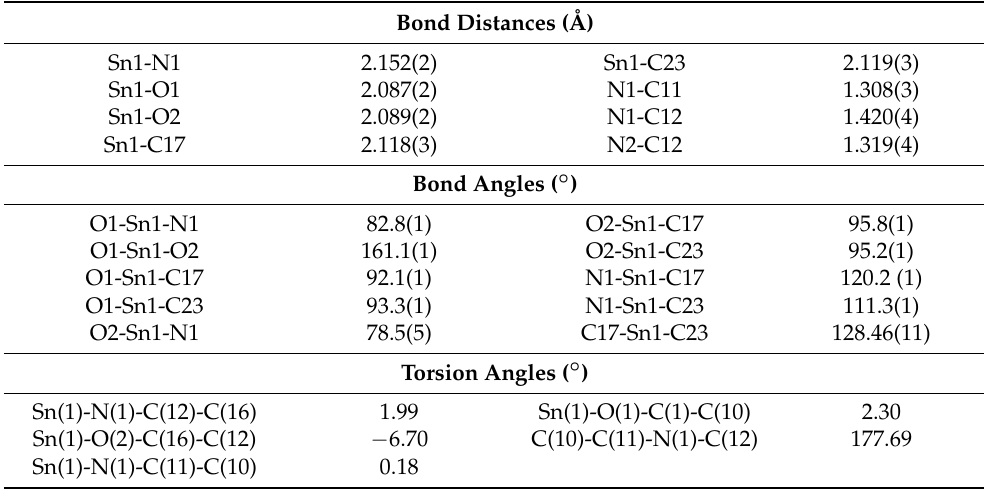
Table 2. Selected bond distances (Å) and angles (°) for compound 1c .